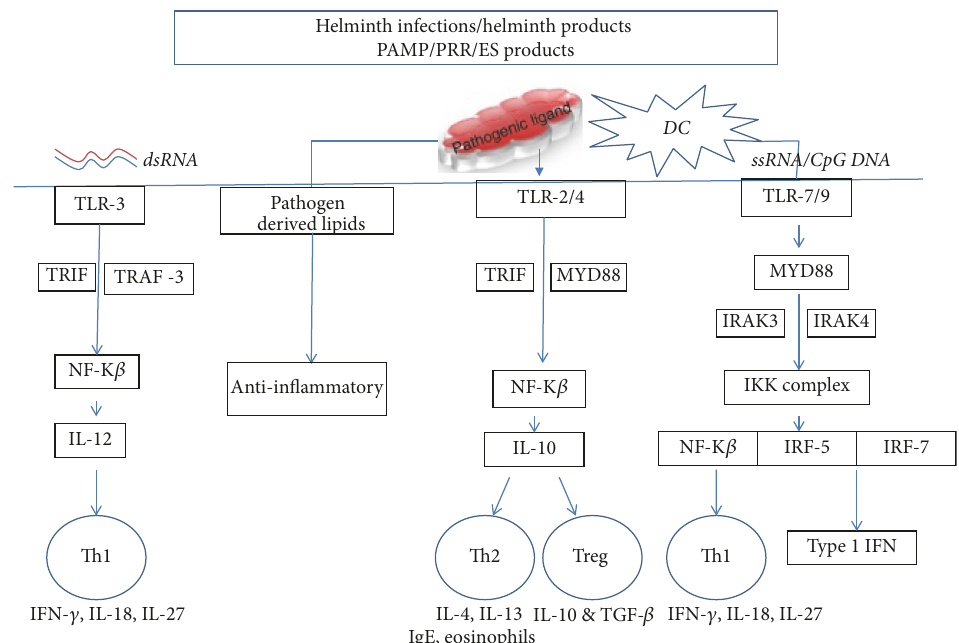
Figure 1: TLR interactions during helminth infections: depicting the involvement and induction of various TLRs during helminth infections and their byproducts. TLR pathways stimulation endorses specific Th